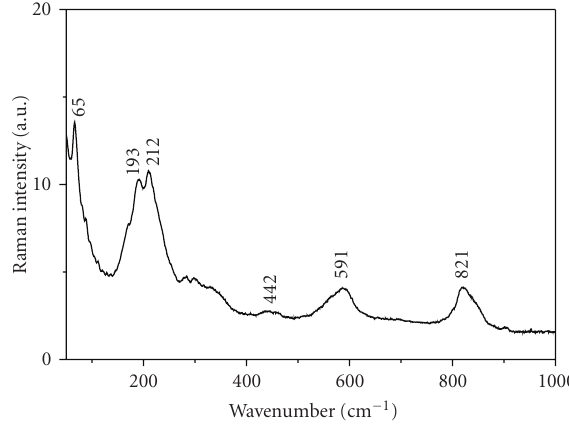
Figure 3: Micro Raman spectra for CBTi144 film deposited by the soft chemical method at 700 ◦ C for 2 hours.